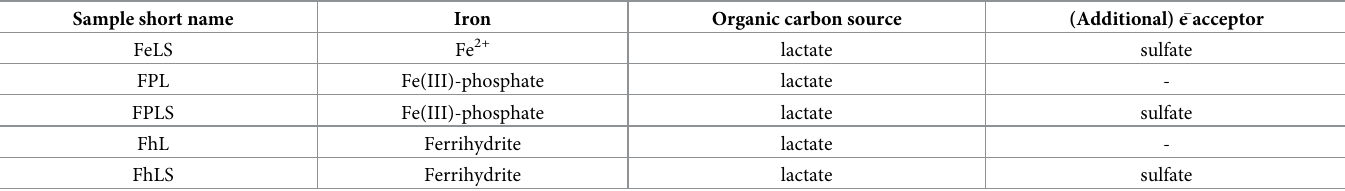
Table 1. Summary of Lake Pavin incubation treatment